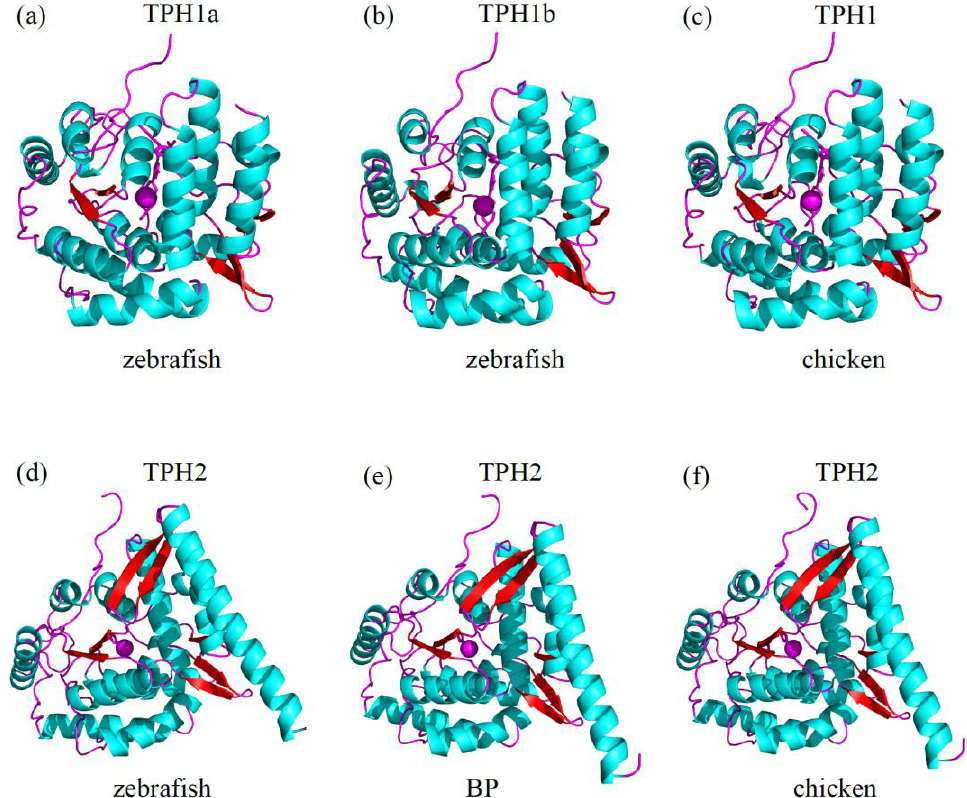
Figure 5. Predicted 3D structures of representative TPH proteins. Comparisons of the 3D structures of zebrafish TPH1a ( a ), zebrafish TPH1b ( b ), chicken TPH1 ( c ), zebrafish TPH2 ( d ), BP TPH2 ( e ), and chicken TPH2 ( f ) are illuminated in Section 3.5. Helices of the catalytic domains and β -strands are colored sky blue and red, respectively. Loop regions are marked in purple.